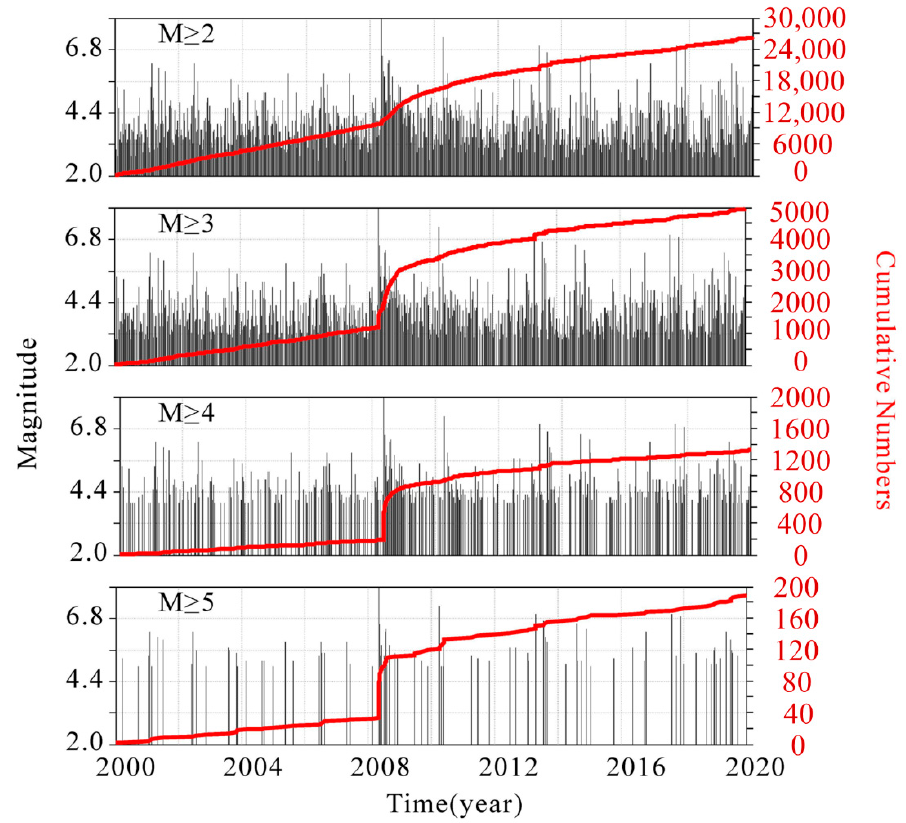
Figure 10. Magnitude and cumulative numbers of seismic events in the study area from 2000 to 2020 using various cutoff magnitudes.